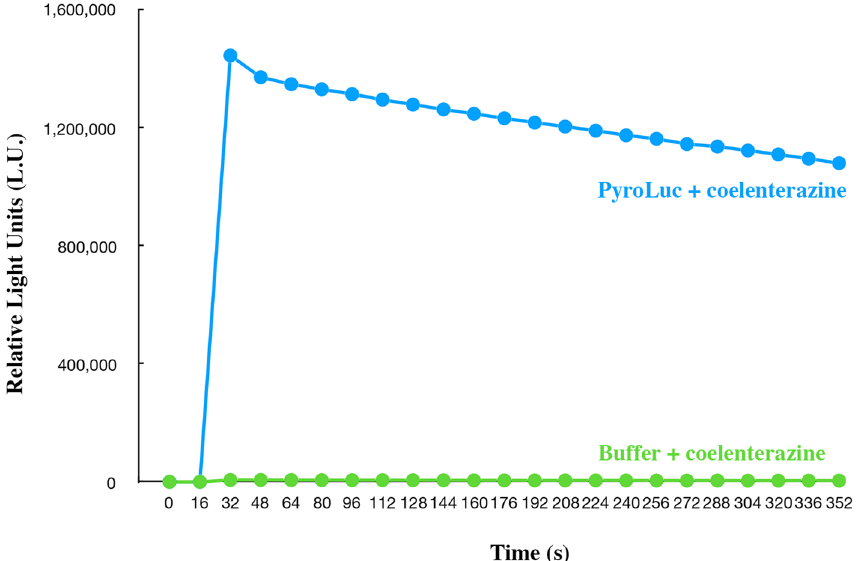
Figure 3. In blue, luminescence reading of purified PyroLuc (3.2 μM) following the addition of coelenterazine (24.5 μM). PyroLuc and coelenterazine were diluted in PBS with 300 mM imidazole, pH 7.4. In green, PBS buffer control with addition of 24.54 μM coelenterazine. Coelenterazine was injected at 16 s for both